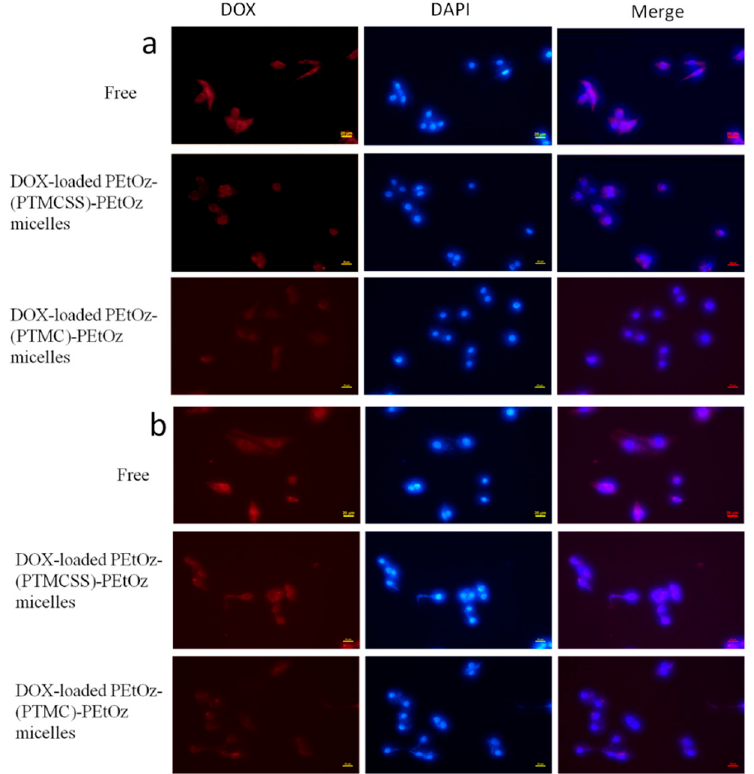
Figure 4. ( a ) Fluorescence microscope images of C6 cells incubated with DOX-loaded PEtOz-PU(PTMCSS)-PEtOz micelles, DOX-loaded PEtOz-PU(PTMC)-PEtOz micelles and free DOX (10 µ g / mL) in 2 h. ( b ) Fluorescence microscope images of C6 cells incubated with DOX-loaded PEtOz-PU(PTMCSS)-PEtOz micelles, DOX-loaded PEtOz-PU(PTMC)-PEtOz micelles and free DOX (10 µ g / mL) in 4 h. For each panel, images from left to right show DOX fluorescence in cells (red), cell nuclei stained by 2-(4-Amidinophenyl)-6-indolecarbamidine dihydrochloride (DAPI, blue) and overlays of two images. The scale bars correspond to 20 µ m in all the